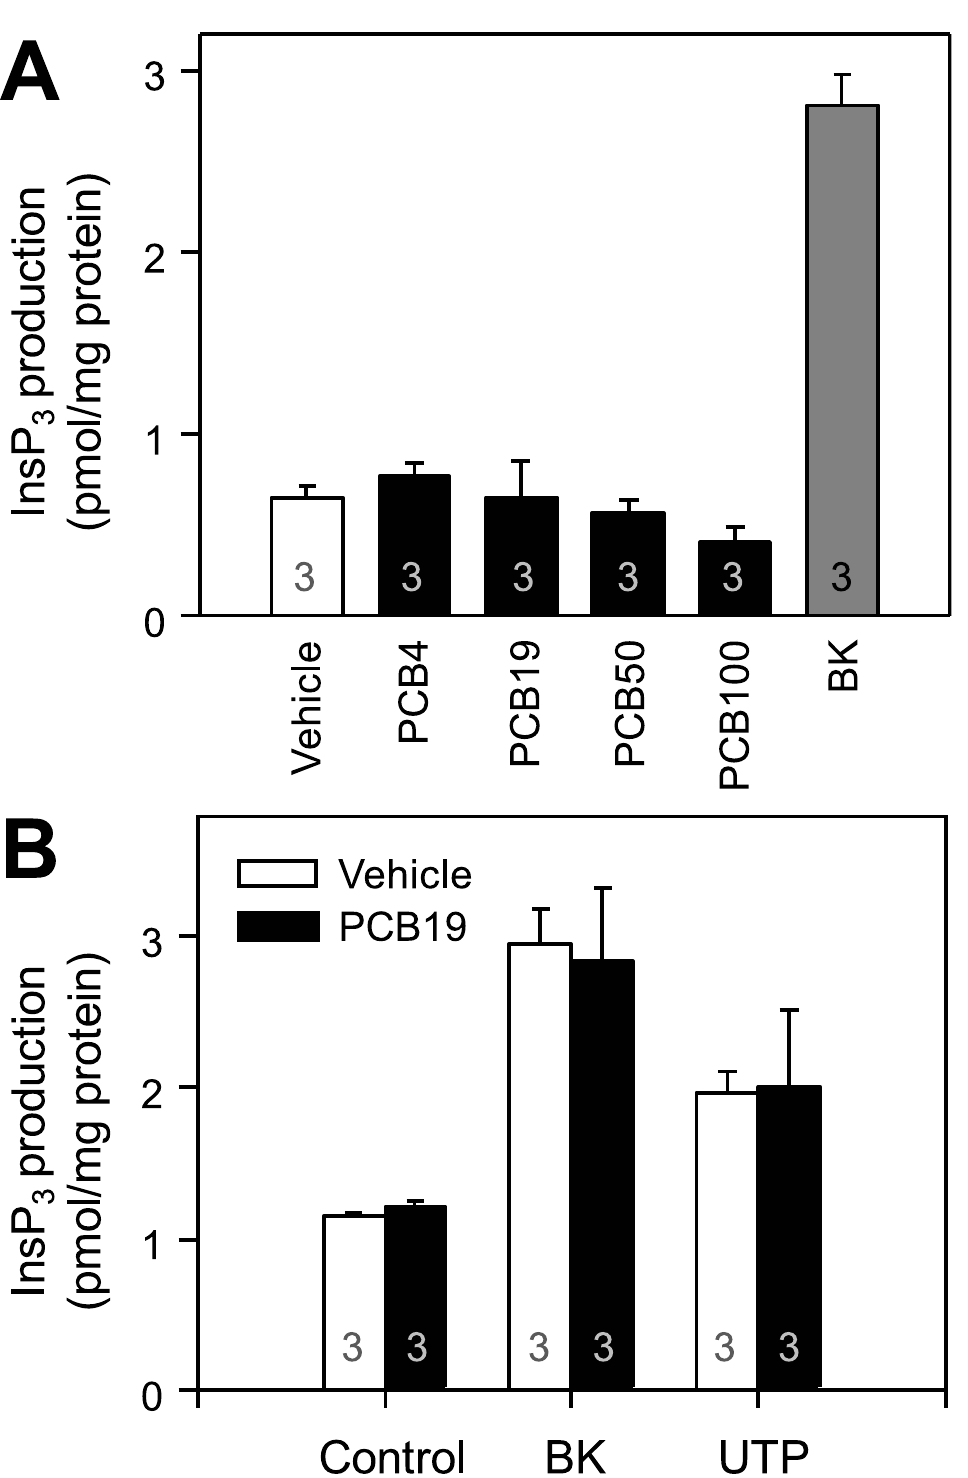
Fig 3. PCB19 does not affect InsP 3 production. A, PC12 cells were treated with 50 μ M PCB4, PCB19, PCB50, or PCB100, or 300 nM bradykinin, for 15 seconds. Subsequently, InsP 3 production was measured. B, Cells were preincubated either with (black bar) or without (blank bar) 50 μ M PCB19 for 3 min and then treated with 300 nM bradykinin for 15 seconds. Number of experiments are depicted in bar graph and each point represents mean ± SEM. BK,